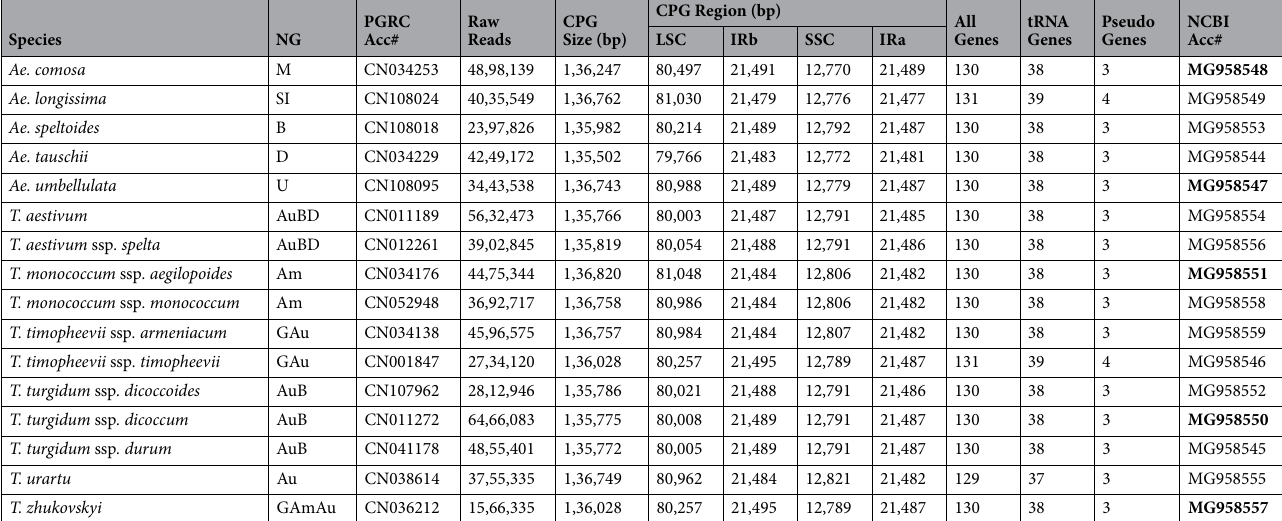
Table 1. List of 16 samples representing five Aegilops and six Triticum species and their chloroplast genome assemblies, annotations and GenBank accessions. The new circular chloroplast genome assemblies with annotations are highlighted in bold for NCBI accessions. NG nuclear genome designation, PGRC Plant Gene Resources of Canada, Acc # accession number, CPG chloroplast genome, LSC large single copy, SSC small single copy, IRa and IRb two inverted repeat regions, NCBI National Center for Biotechnology